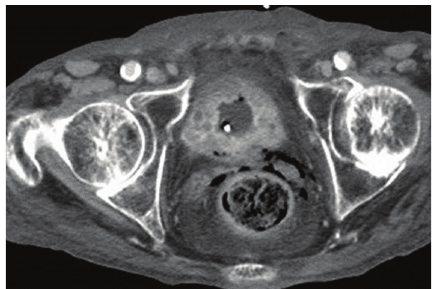
Figure 3: Free intraperitoneal air is identified (arrowhead).